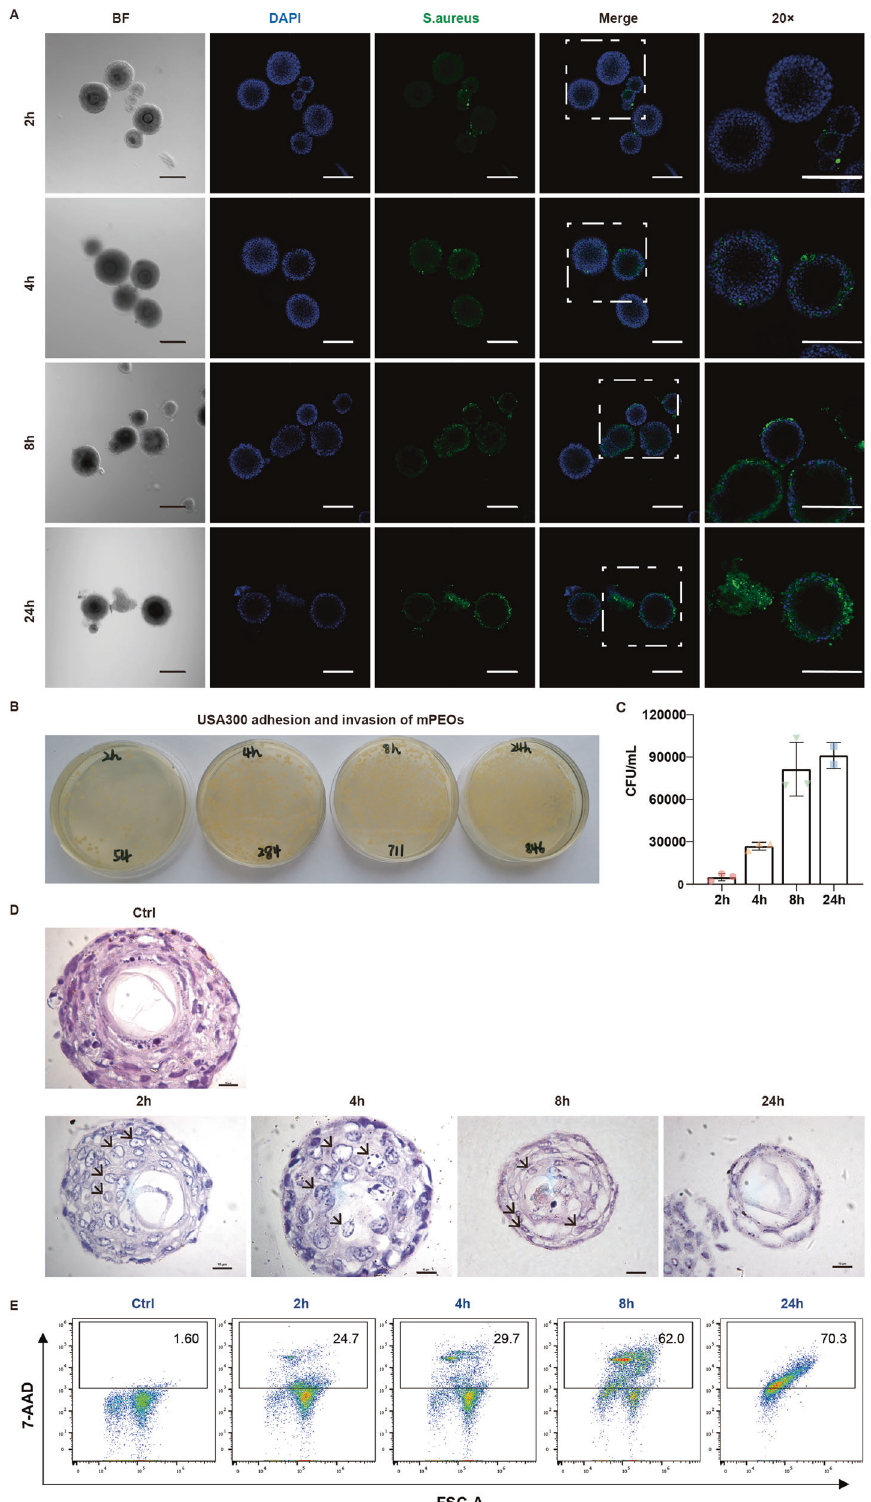
Fig. 4 Modeling USA300 skin infection in mPEOs. A Immuno fl uorescence staining analysis of Staphylococcus aureus -speci fi c biomarkers in mPEOs at 2, 4, 8, and 24 h of infection (scale bars, 200 μ m). B , C CFU count of USA300 invading mPEOs at 2, 4, 8, and 24 h after gentamicin treatment for one hour. D H&E staining of infected mPEOs at 2, 4, 8, and 24 h (scale bars, 10 μ m). E Flow cytometry 7-ADD staining results to assess the cell viability of mPEOs at 2, 4, 8, and 24 h of infection.